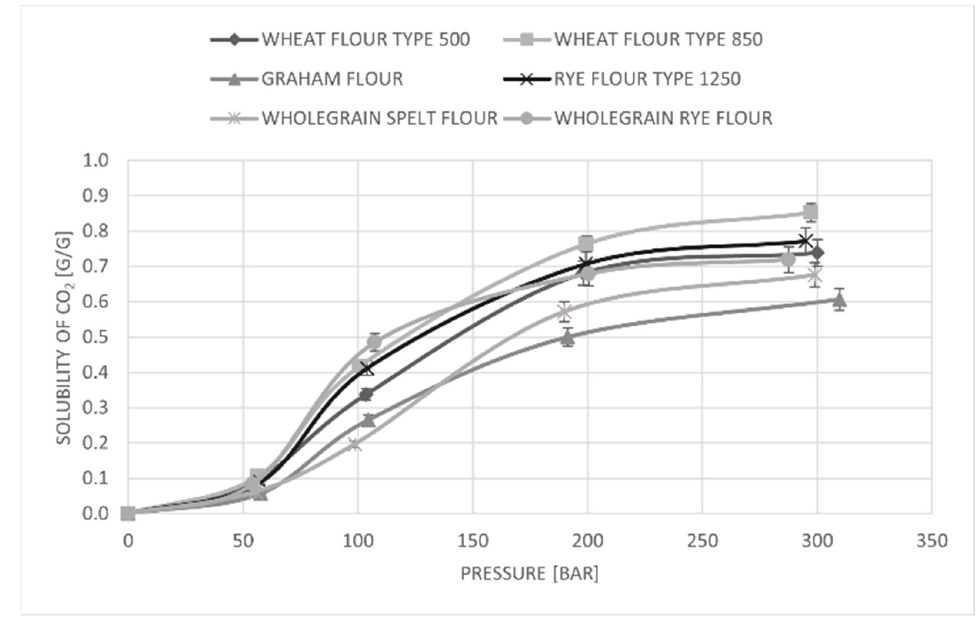
Figure 4. Comparison of CO 2 solubility in different flour types at 35 °C.